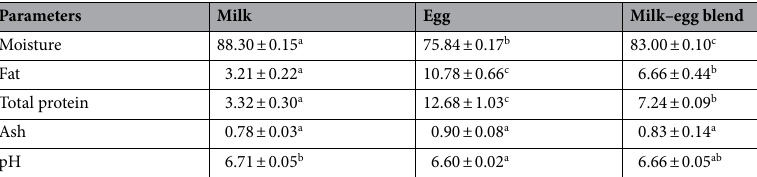
Table 1. Composition (g 100 g −1 ) and acidity characteristics of raw milk, raw egg and milk–egg blend. a,b — different letters in the row denote statistically significant differences between the results (P < 0.05); ± means